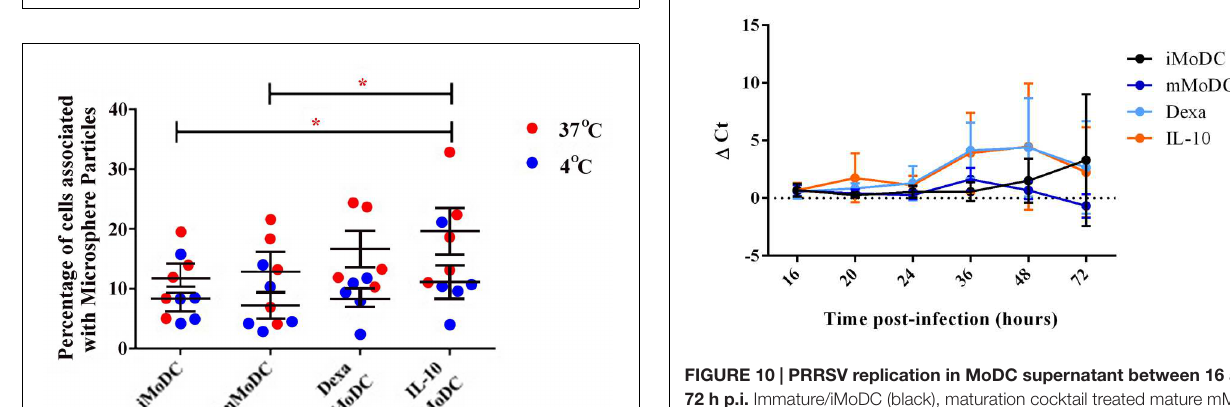
FIGURE 7 | The effect of dexa treatment on MoDC levels of endocytosis. The ability of immature/iMoDC (untreated), mature/mMoDC (maturation cocktail treated) to endocytose APC ∗ -labeled OVA was assessed. Cells were incubated with OVA at 4 ◦ C as a negative control (blue dots), or at 37 ◦ C (red dots), for 1 h before flow cytometric analysis of APC ∗ fluorescence. Each dot represents the percentage of cells fluorescing APC ∗ , indicating endocytic OVA uptake, in individual experiments. Lines represent mean percentages of cells associated with OVA-APC ∗ ± SEM. One-way ANOVA was used to assess significance followed by Bonferroni’s multiple comparison test, ∗ p < 0.05.